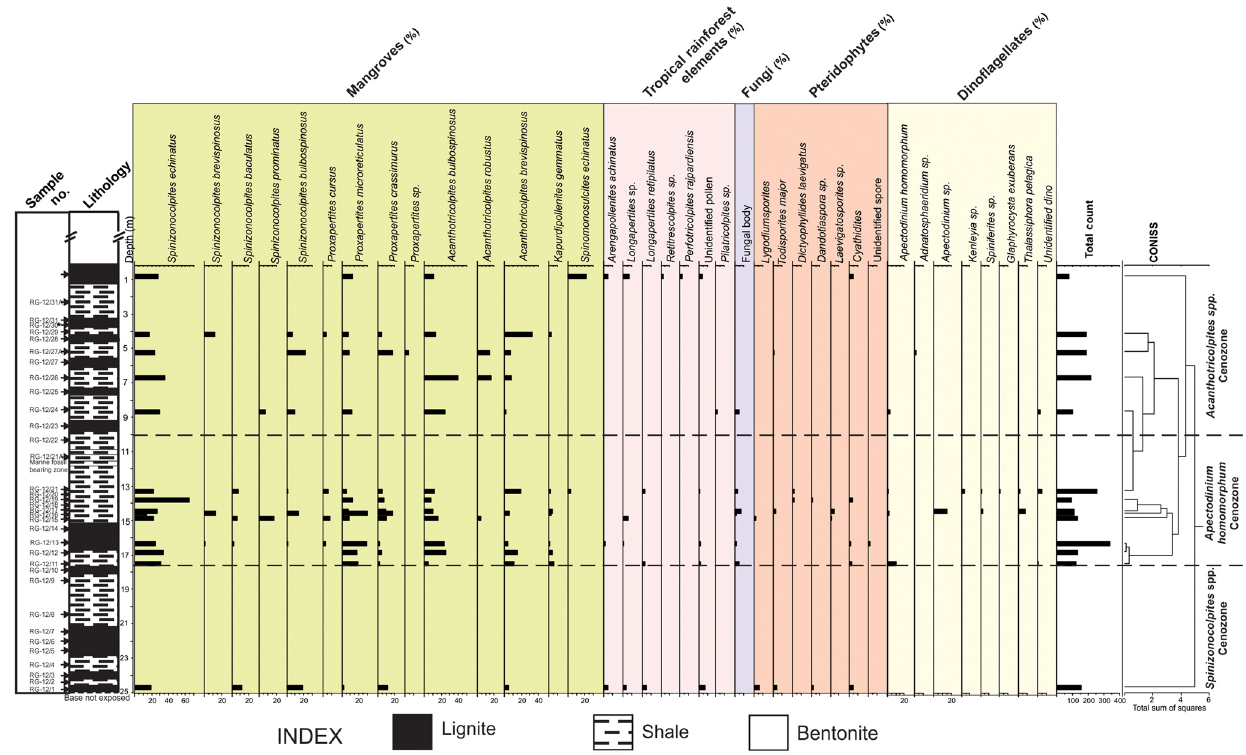
Figure 3. Percentage distribution of palynomorphs in the Giral lignite mine section, Barmer